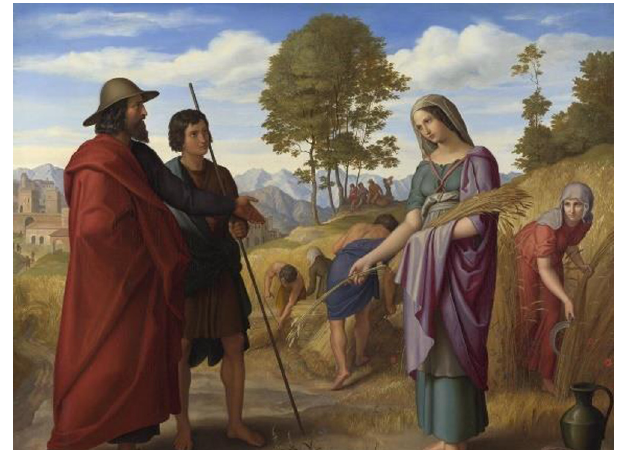
Figure 4: Julius Schnorr von Carolsfeld, Ruth in Boaz ’ s Field ,